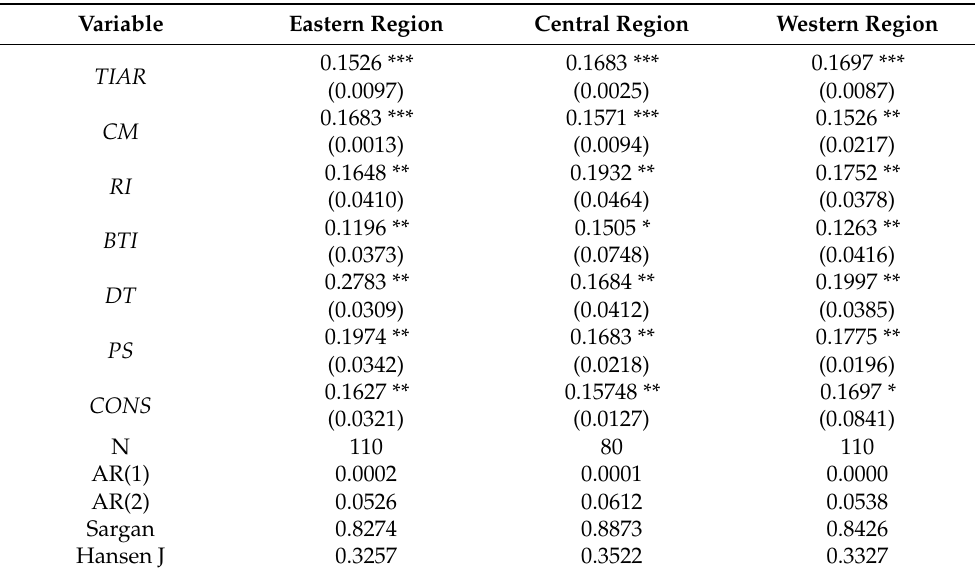
Table 8. Regression Analysis on Influencing Factors of Low Carbon Development of Electric Power Industry in